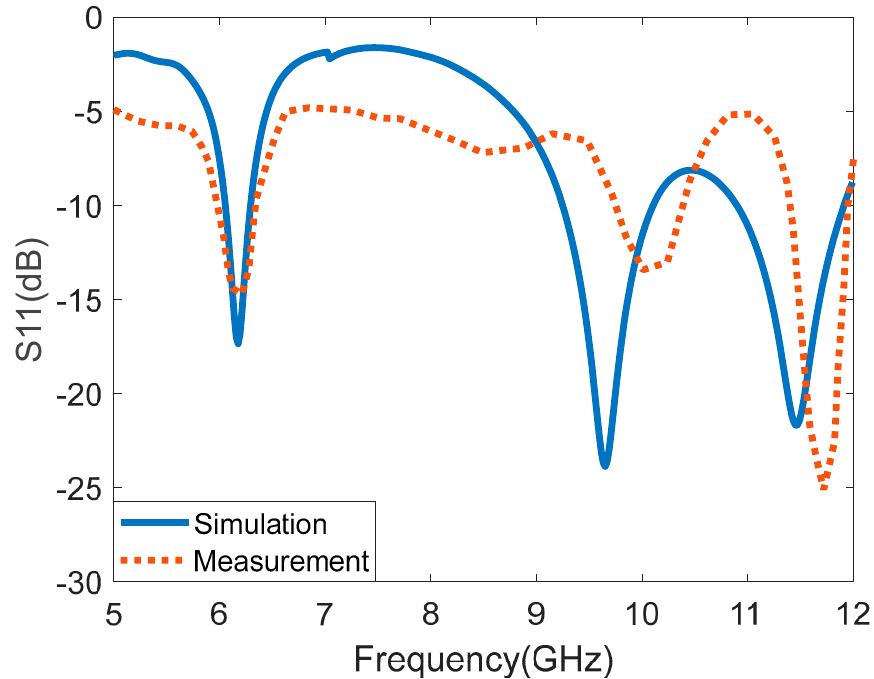
Figure 7. Simulated and measured reflection coefficient ( 𝑆11 ) of the antenna.